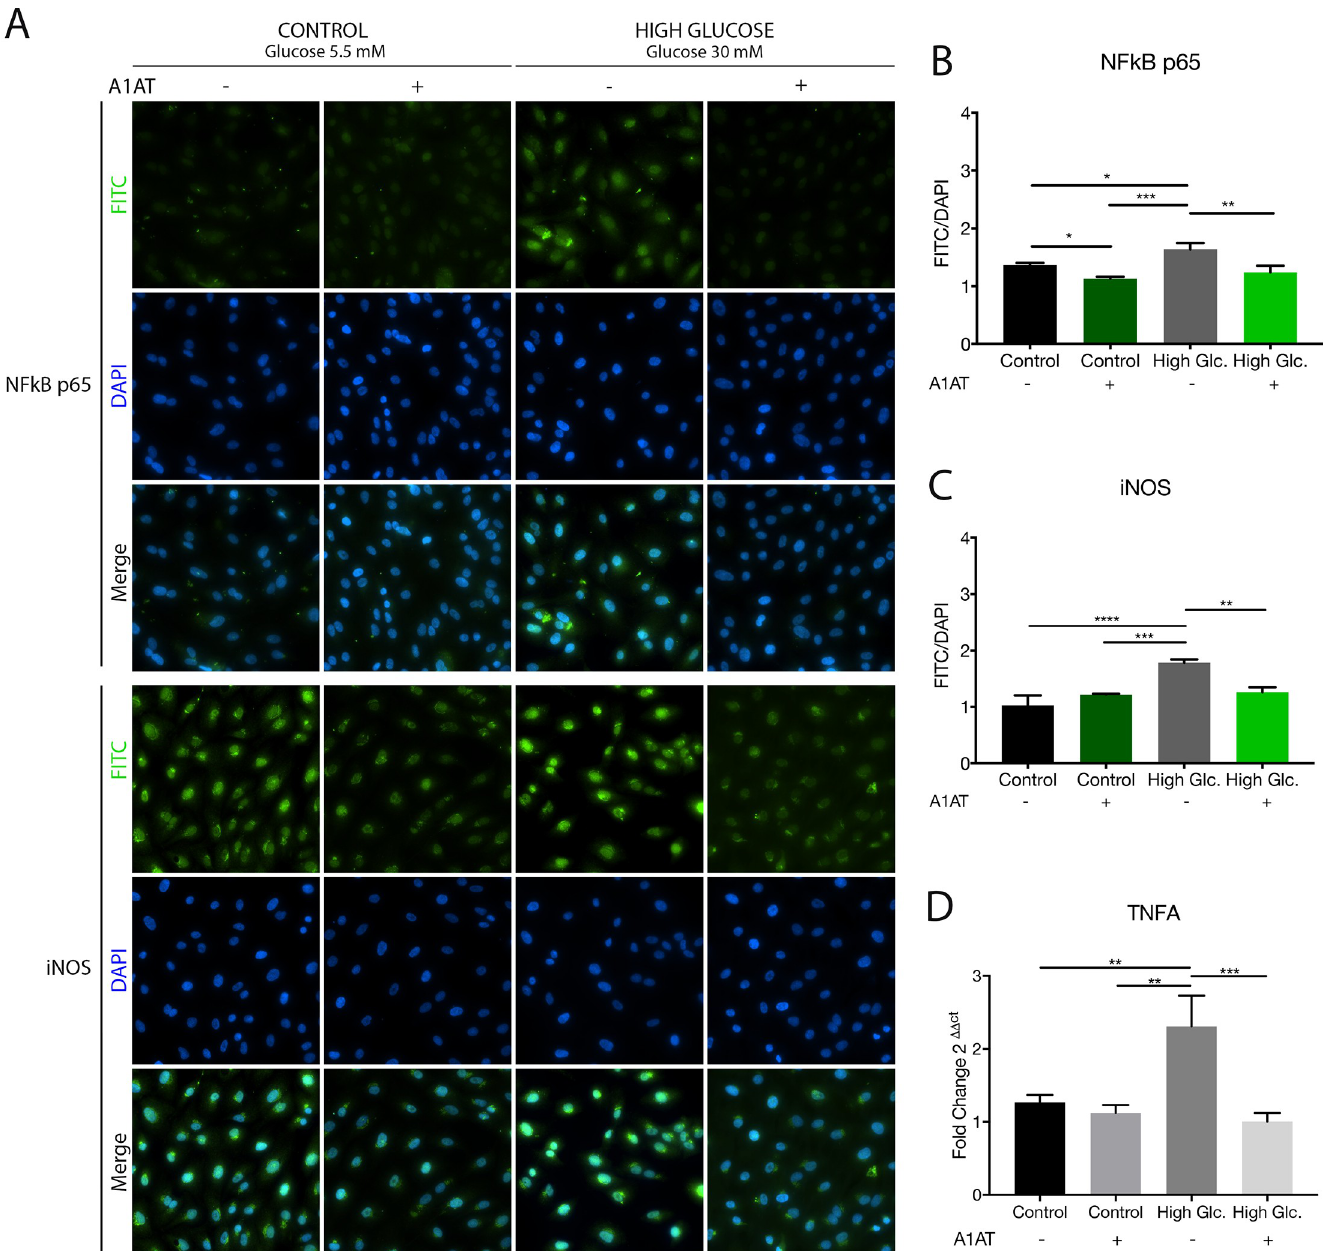
Fig 2. Reduced expression of NF κ B and inflammation related targets iNOS and TNF- α on high glucose group treated with A1AT. (A) Representative microphotographs of NF κ B p65 and iNOS immunohistochemistry and DAPI staining under control, high glucose and A1AT treatment culture conditions; total magnification 400X (10X ocular lenses and 40X objective). (B and C) Quantification of immunofluorescence assay, data expressed as mean of FITC fluorophore signal vs. DAPI signal ± SD (n = 5). (D) TNF- α mRNA expression levels measured by RT-qPCR. High glucose group expressed as ‘High Glc’. Data expressed as fold change with respect to control. � p < 0.05, �� p < 0.01, ��� p < 0.001 vs.